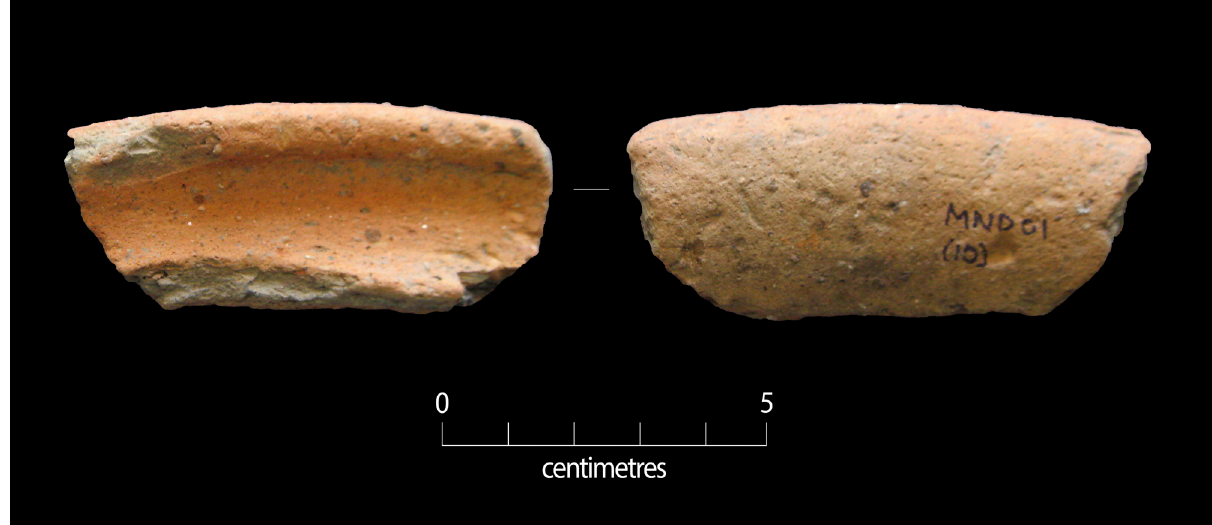
Figure 44: External and internal surfaces of a Class 16 variant 2